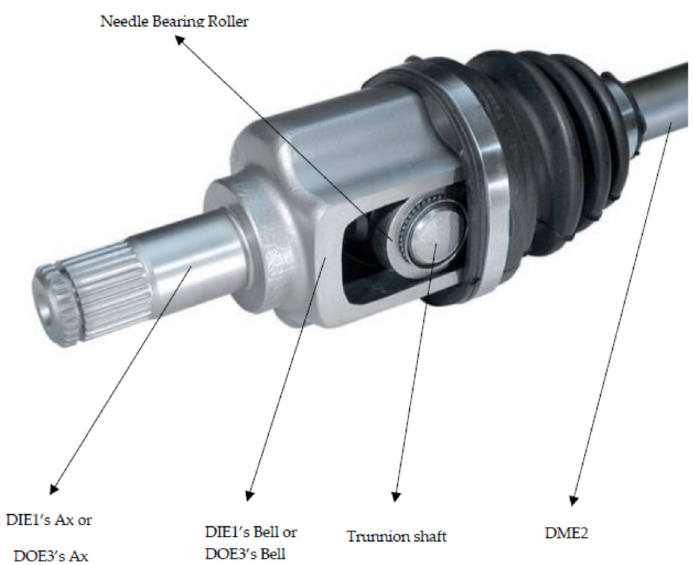
Figure 6. Picture of DTID’s DIE1(TJ1 with DME2) or DOE3(TJ2 with DME2).